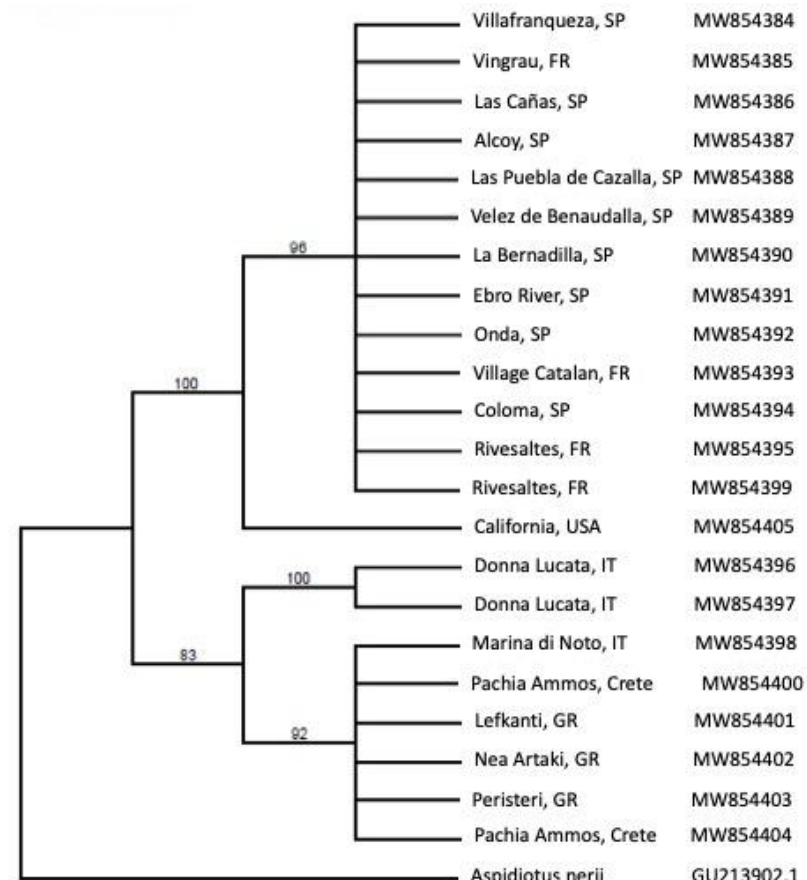
Figure 5. Maximum parsimony 50% majority consensus cladogram of 127 trees of cytochrome c oxidase subunits 1 and 2 mtDNA region for Rhizaspidiotus donacis and outgroup ( Aspidiotus nerii ). Bootstrap values are shown above branches. Collection sites and GenBank accession numbers are at the tips of the tree.